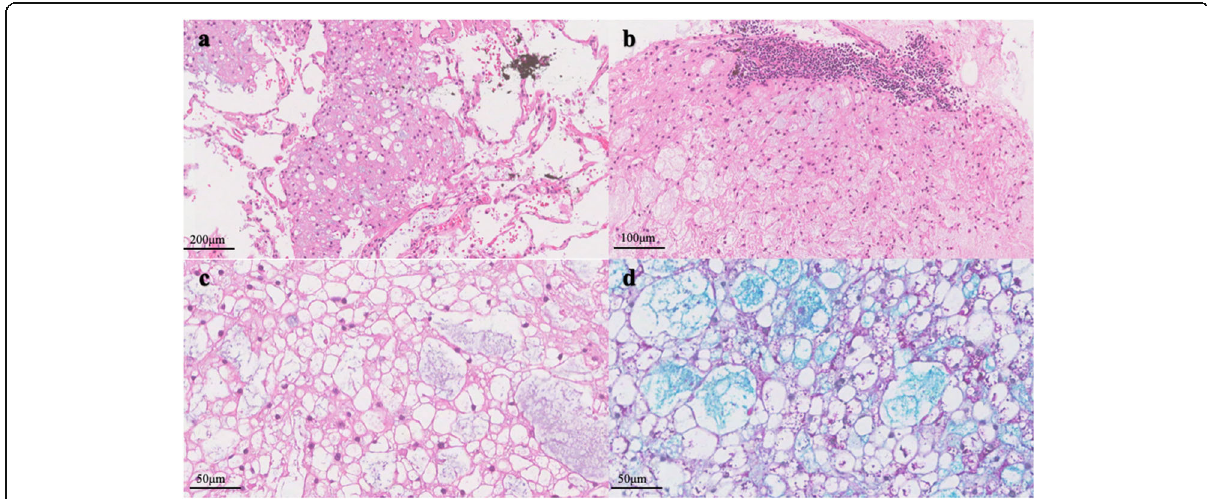
Fig. 2 The tumor was unencapsulated, but well demarcated, minimal destruction of the alveolar structure (a) and cuffs of lymphocytes were observed at the board (b). The tumor cells were vacuolated and resembled mature adipose cells with bland nuclei (c), intracellular mucous (d) was positive for AB/PAS staining